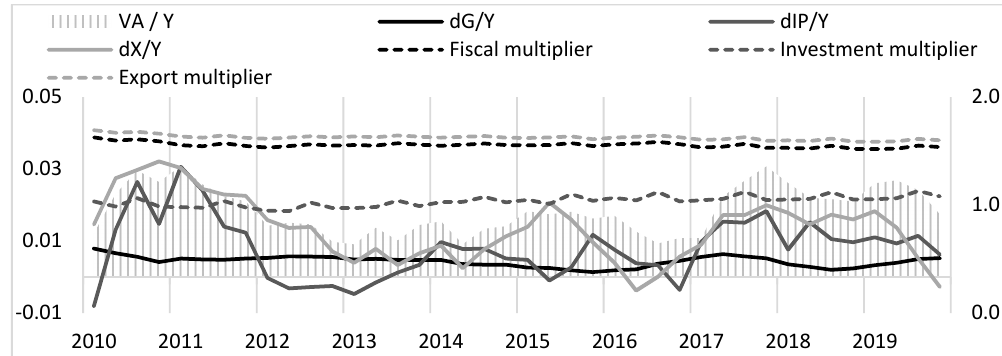
Figure 9. Growth rate of gross value added in relation to 𝐺𝐷𝑃 , own work, source: Eurostat. Figure 10. Growth rate of gross value added (main variables)—France, own work, source: Eurostat.